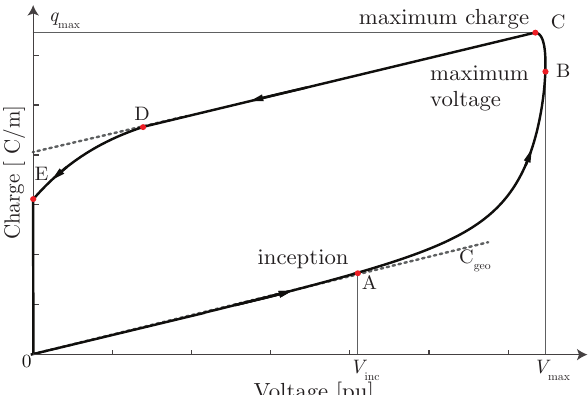
Figure 1. Representation of the main branches of the typical hysteretic relation between p.u.l. charge and applied voltage with corona